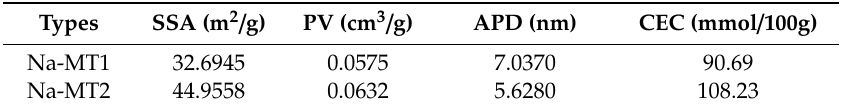
Table 2. Specific surface area (SSA), pore structure, and cation exchange capacity (CEC) of two kinds of Na-MT.